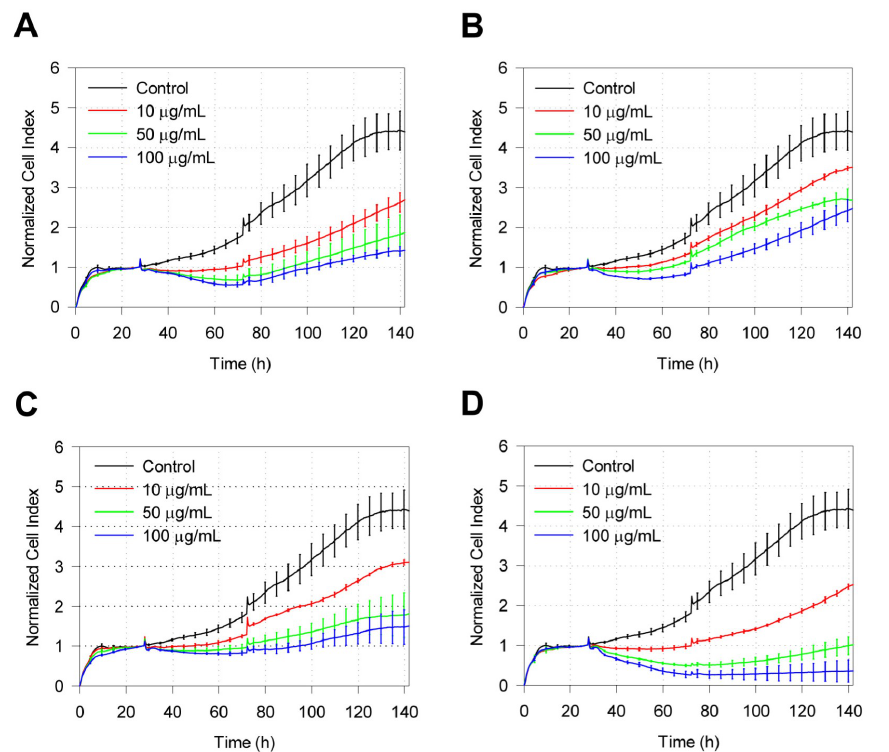
Figure 3. Dynamic assessment of the viability of IMR-90 cells exposed to zeolite particles. Exposing IMR-90 cells to different concentrations of zeolite particles (10, 50, and 100 µ g/mL). The CI values were normalized at the time of the zeolite treatment for the following crystal structures: ( A ) LTL-R, ( B ) LTL-D, ( C ) MFI-S, and ( D ) FAU-S. Control cells cultured in zeolite-free media were run parallel to treatment group. Experiments were performed in quadruplet and presented as mean ± SD (n = 3). CI, cell